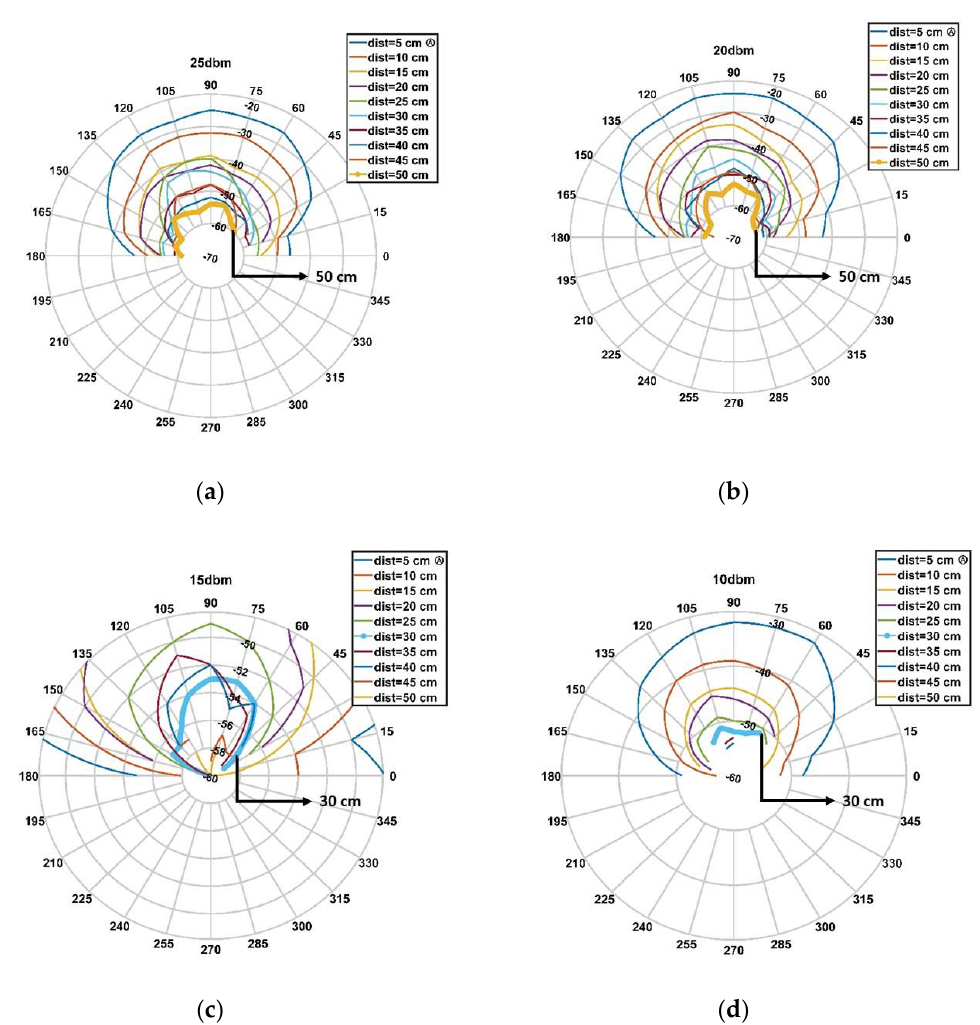
Figure 5. Characterization results. The tag irradiated power: ( a ) when the output power is fixed to 25 dBm, ( b ) when fixed to 20 dBm, ( c ) when fixed to 15 dBm, and ( d ) when fixed to 10 dBm.